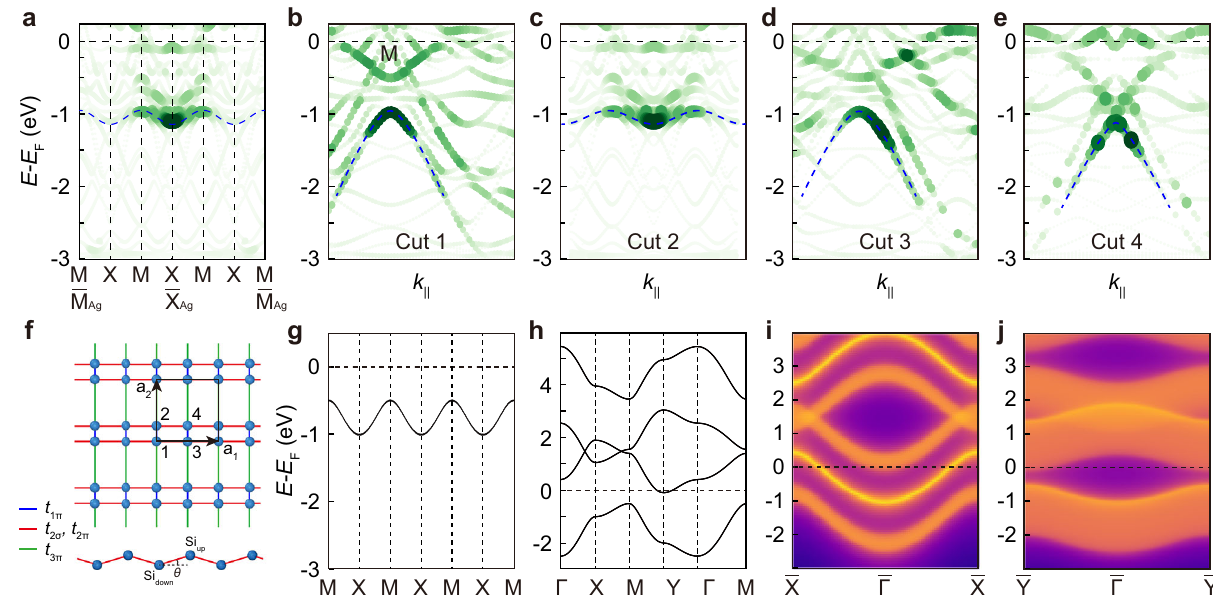
drawing of the TB model. There are four Si atoms in each unit cell, as indicated by the numbers 1-4. g , h Calculated band structure based on the TB model. Para- meters: t 1 π =1 : 2eV, t 2 σ = t 2 π =1 : 15eV, t 3 π =0 : 25eV, and U 1 =2 : 5eV, U 2 =0 : 45eV. i Edge spectrum of the nontrivial edge which is obtained by cutting the system throughthecentersofthebluebonds(theWanniercenter)inthe y direction. j Edge spectrum of the trivial edge by cutting the bonds in the x